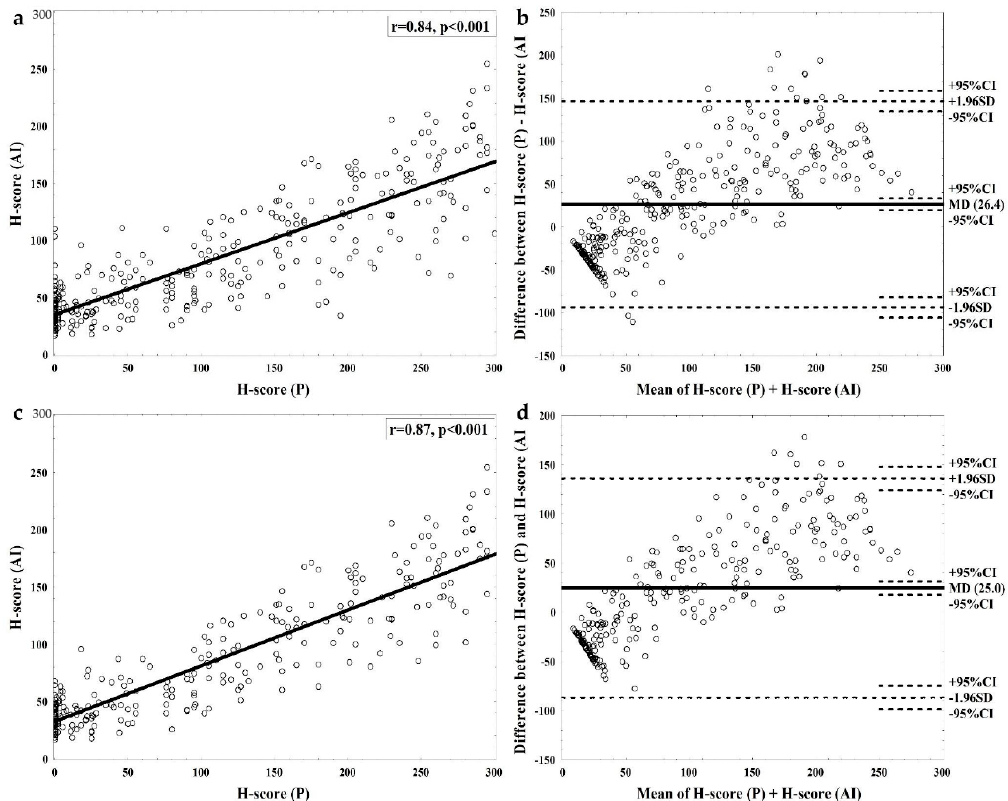
Figure 2. Analysis of interrater reliability of FGFR2 staining assessment. ( a ) A regression plot